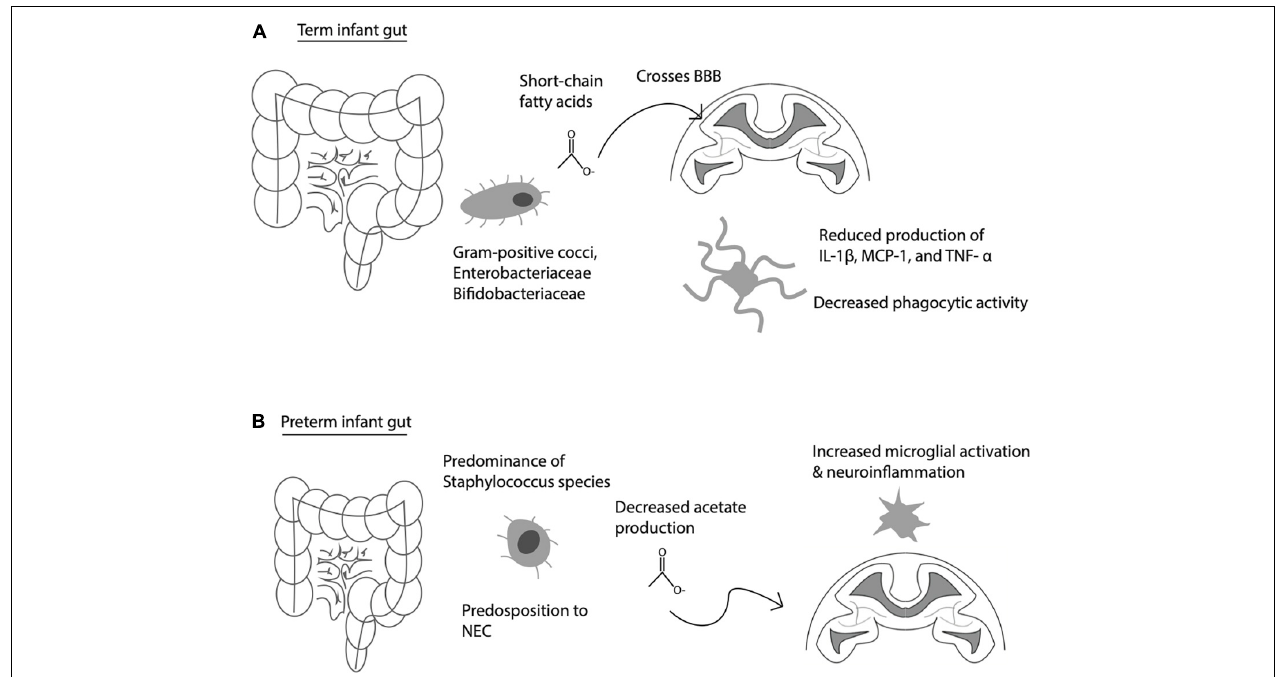
FIGURE 1 | Communication between gut-derived short chain fatty acids (SCFA) and brain immune activity. (A) Normal interaction between gut-derived SCFA, which cross the blood brain barrier (BBB) to influence microglia activity under physiological conditions. (B) Premature infant gut with altered gut flora, predisposition to necrotizing enterocolitis (NEC), decreased acetate production, leading to increased microglial activation, and increased risk of